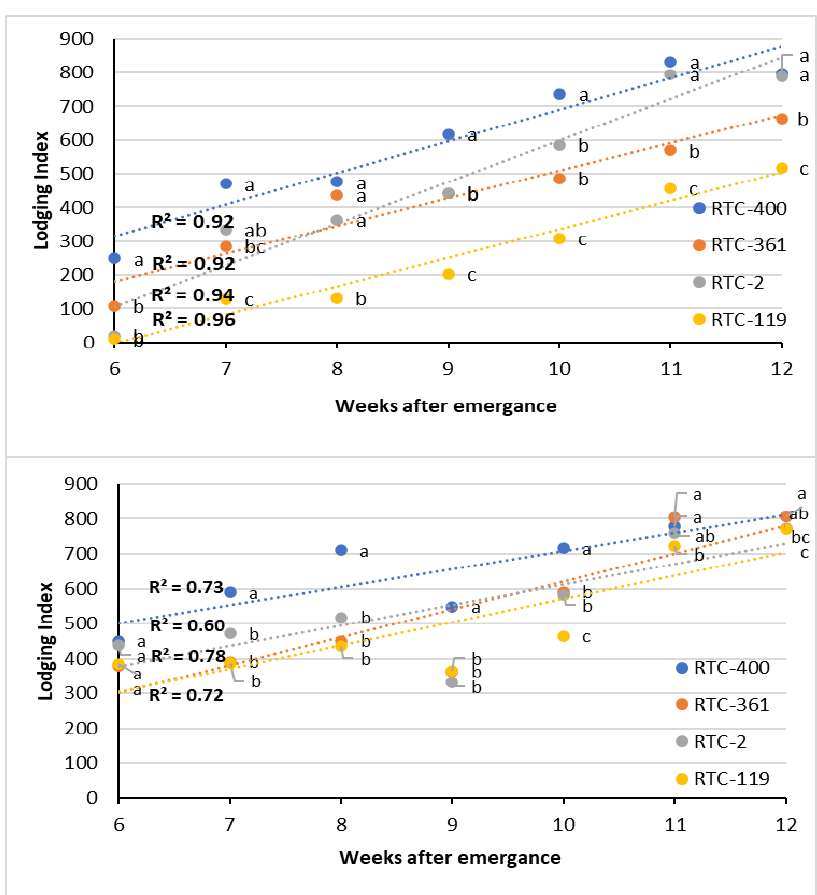
Figure 6. Lodging development (expressed as lodging index) between week 6 and 12 (season end) in 2018 (top) and 2019 (bottom). Data were averaged across sowing rates for the four genotypes: RTC-400 (blue), RTC-2 (grey), RTC-361 (red), and RTC-119 (orange). Linear fits and their R 2 values are presented. Different letters at a given time point indicate significant differences at P < 0.05.